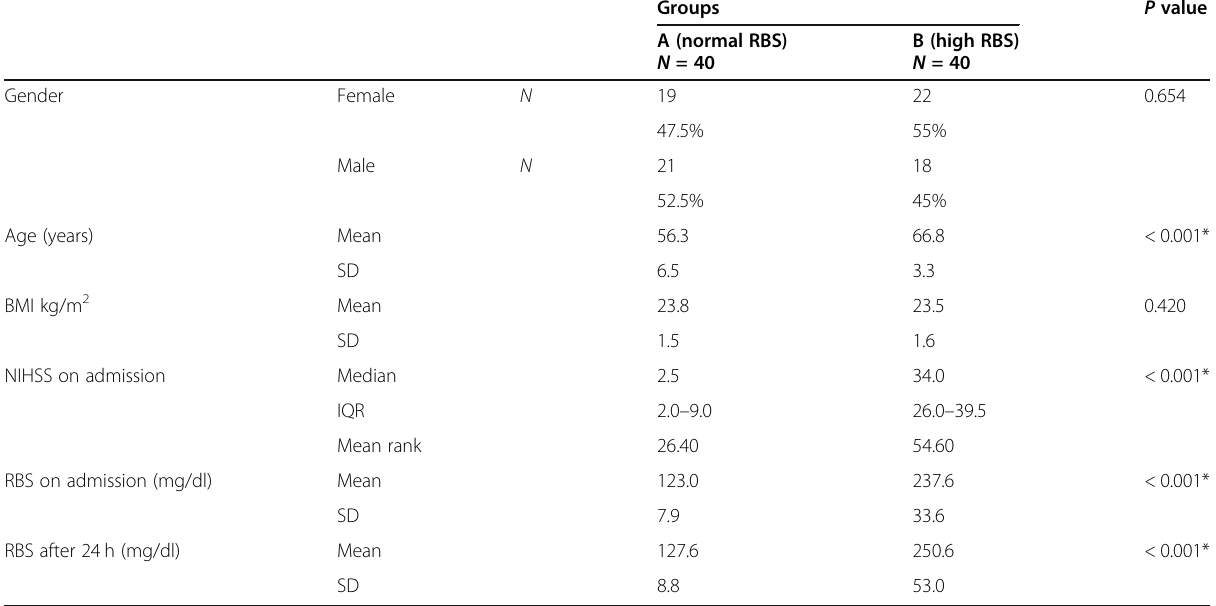
Table 1 Baseline characters of the studied groups